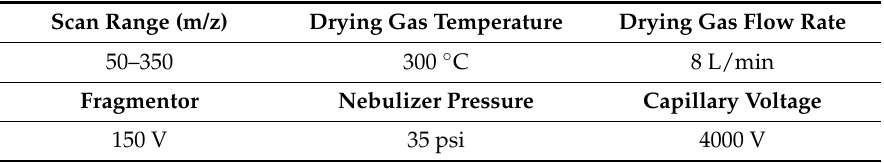
Table 2. MS operation conditions.